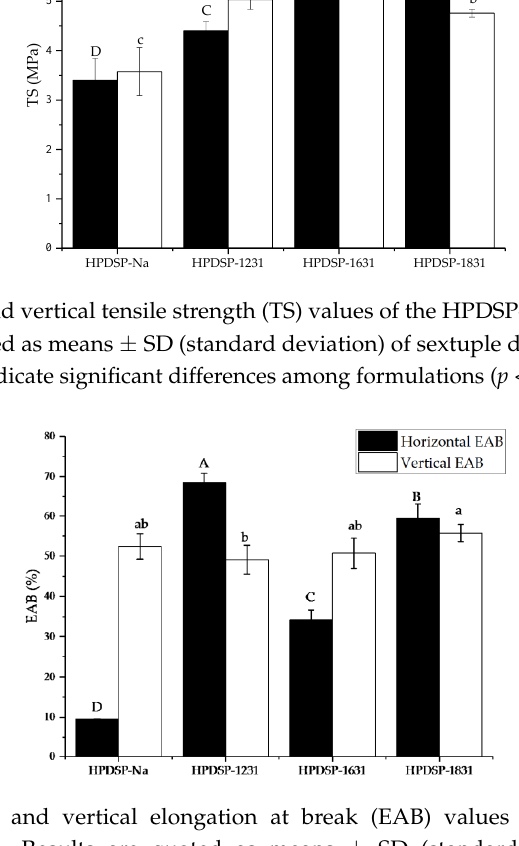
Figure 4. Horizontal and vertical tensile strength (TS) values of the HPDSP-Na and HPDSP-OMMT